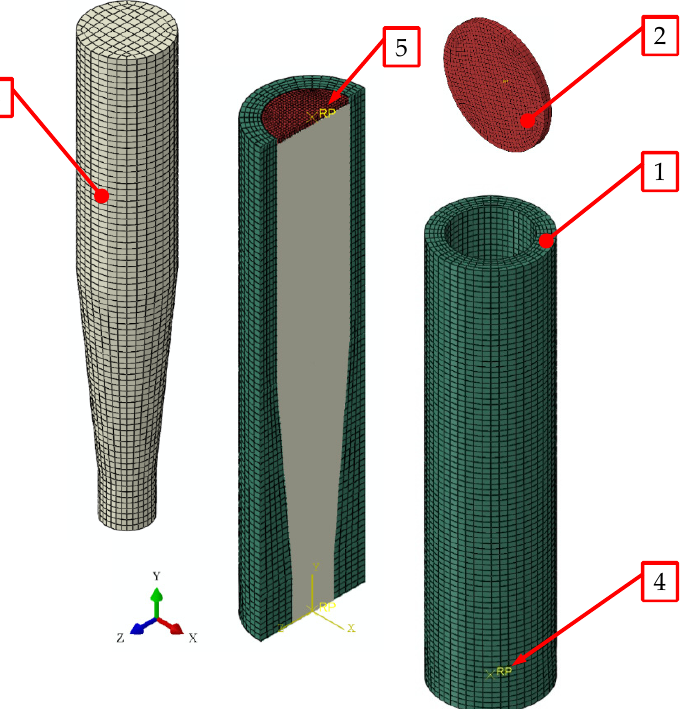
Figure 4. Discretization by finite elements of the model used in the numerical analysis of the process of extrusion: 1—single-hole die integrated with feed barrel, 2—ram, 3—solid, compressed carbon ice snow, 4—reference point on the die, 5—reference point on the ram. The model is composed of three parts represented by finite elements (Figure 4). The main element is the single-hole die (1), integrated with the feed barrel to simplify the model, with a good effect on the uniformity of the finite element mesh. Inside the cylindrical part there is a compression ram (2), which moves by sliding with zero friction. The extruded material (3), i.e., dry ice snow, was modelled as an axisymmetric solid, corresponding in shape to the integrated single-hole die. Two reference points were